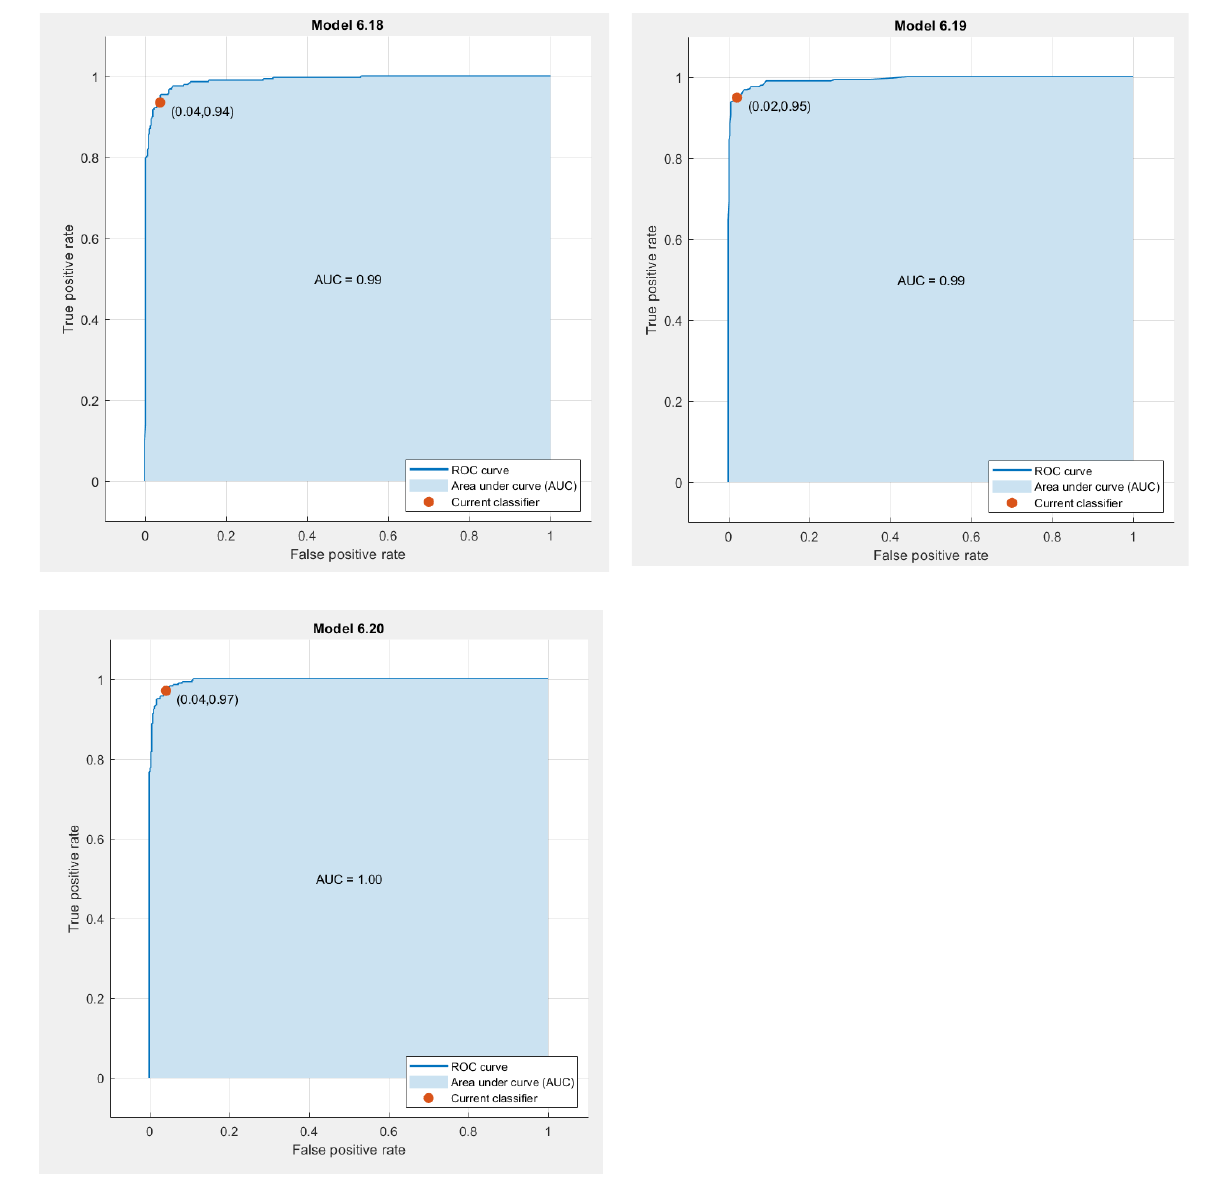
Figure 5. The ROC Curves show AUC values. Order of appearance of sub-figures (from left to right): a = Decision Tree (Model 6.1), b = Linear Discriminant Analysis (Model 6.4), c = Quadratic Discriminant Analysis (Model 6.5), d = Linear Support Vector Machine (Model 6.6), e = Quadratic Support Vector Machine (Model 6.7), f = Cubic Support Vector Machine (Model 6.8), g = Gaussian Support Vector Machine (Model 6.10), h = K-Nearest Neighbor (Model 6.15), i = Boosted Tree Ensemble (Model 6.18), j = Bagged Tree Ensemble (Model 6.19), and k = Subspace Discriminant Ensemble Learner (Model 6.20).